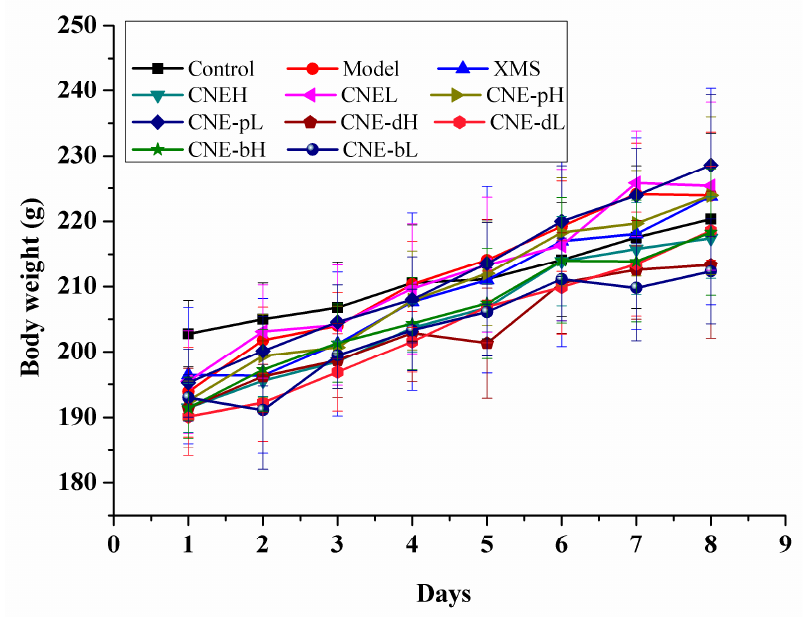
Figure 3. Body weight changes of SD rats treated with different extracts of C. nudiflora .